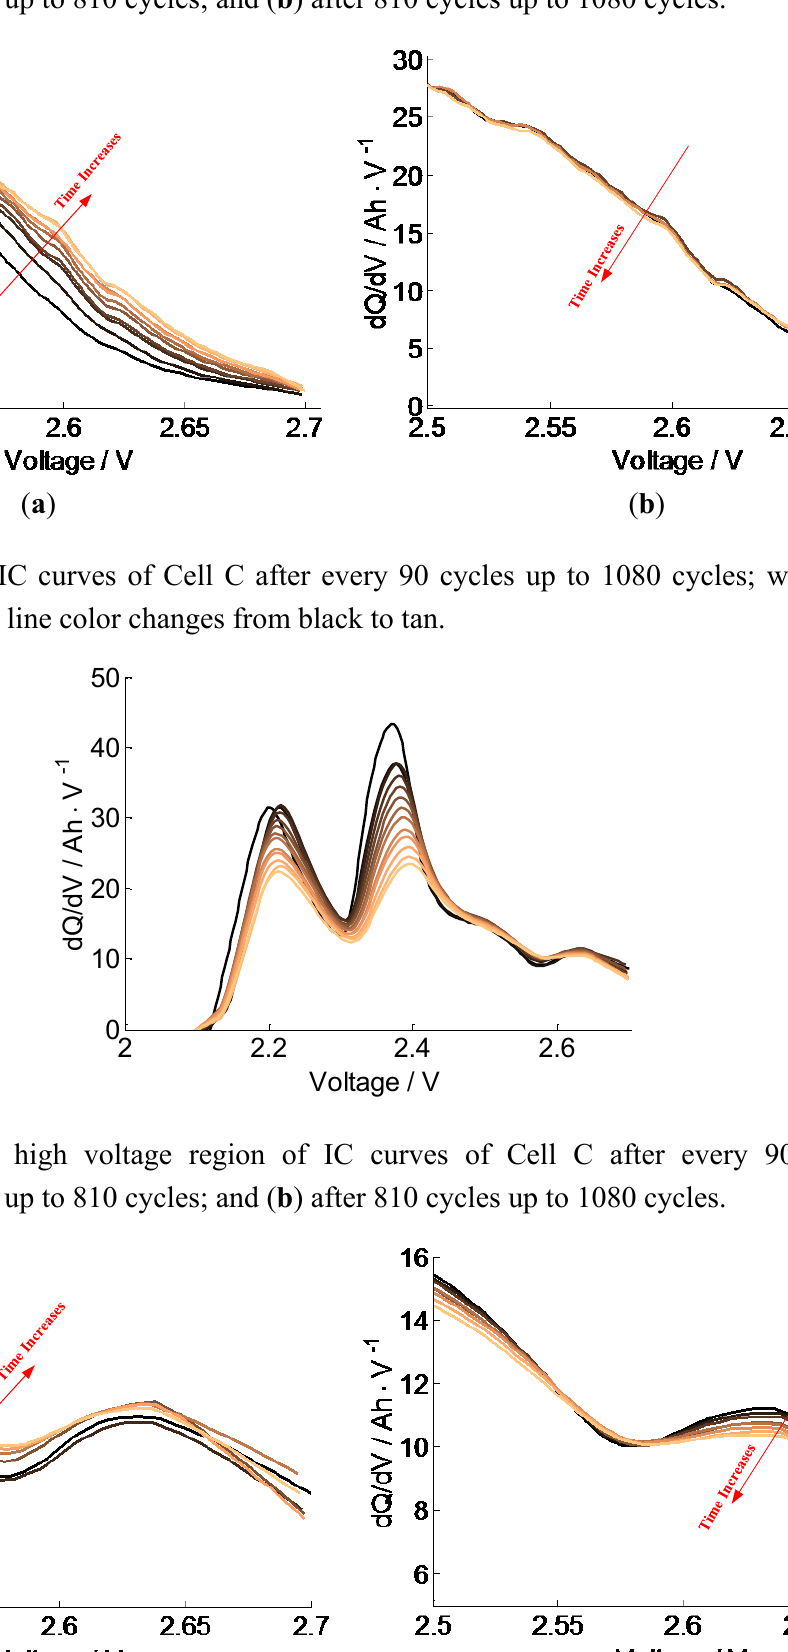
Figure 11. The high voltage region of IC curves of Cell B after every 90 cycles: ( a ) after 0 cycles up to 810 cycles; and ( b ) after 810 cycles up to 1080 cycles.